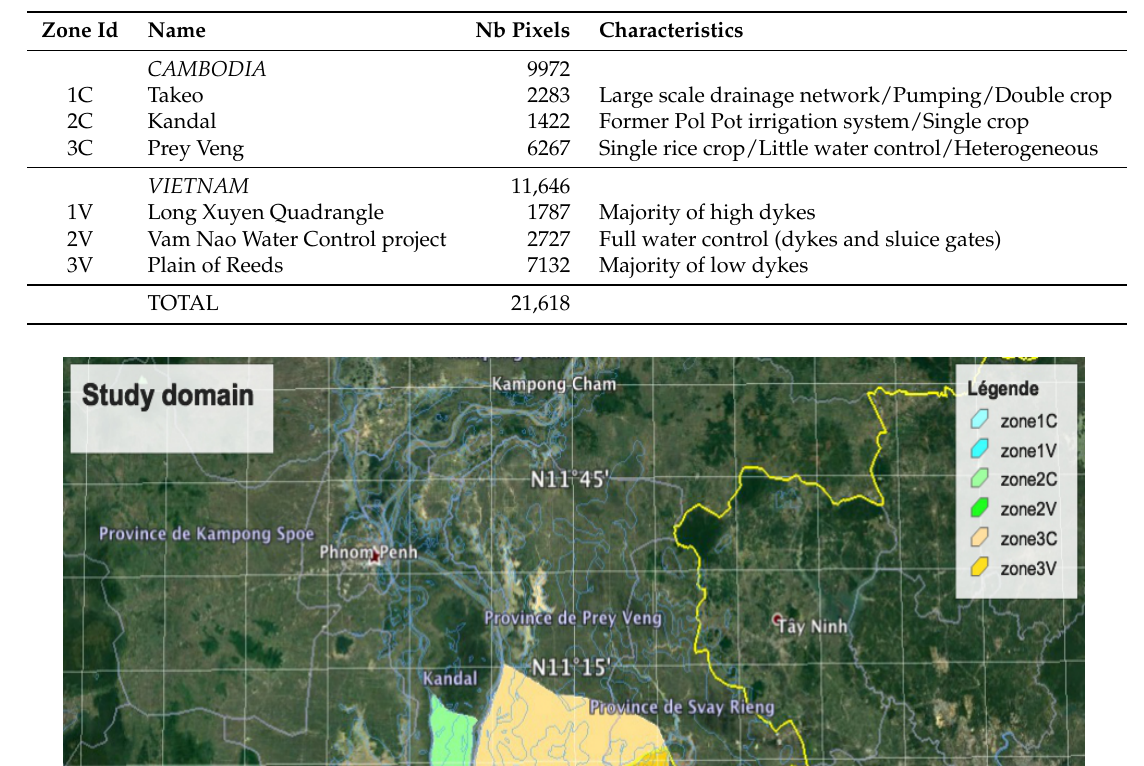
Table 1. Description of the six zones of Figure 1, over Cambodia (top) and Vietnam (bottom). Each pixel is about 500 m × 500 m = 0.25 km 2 .